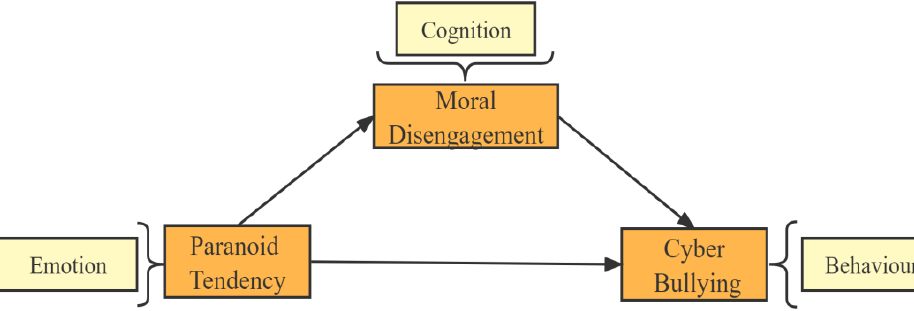
Figure 1. Theoretical framework diagram .